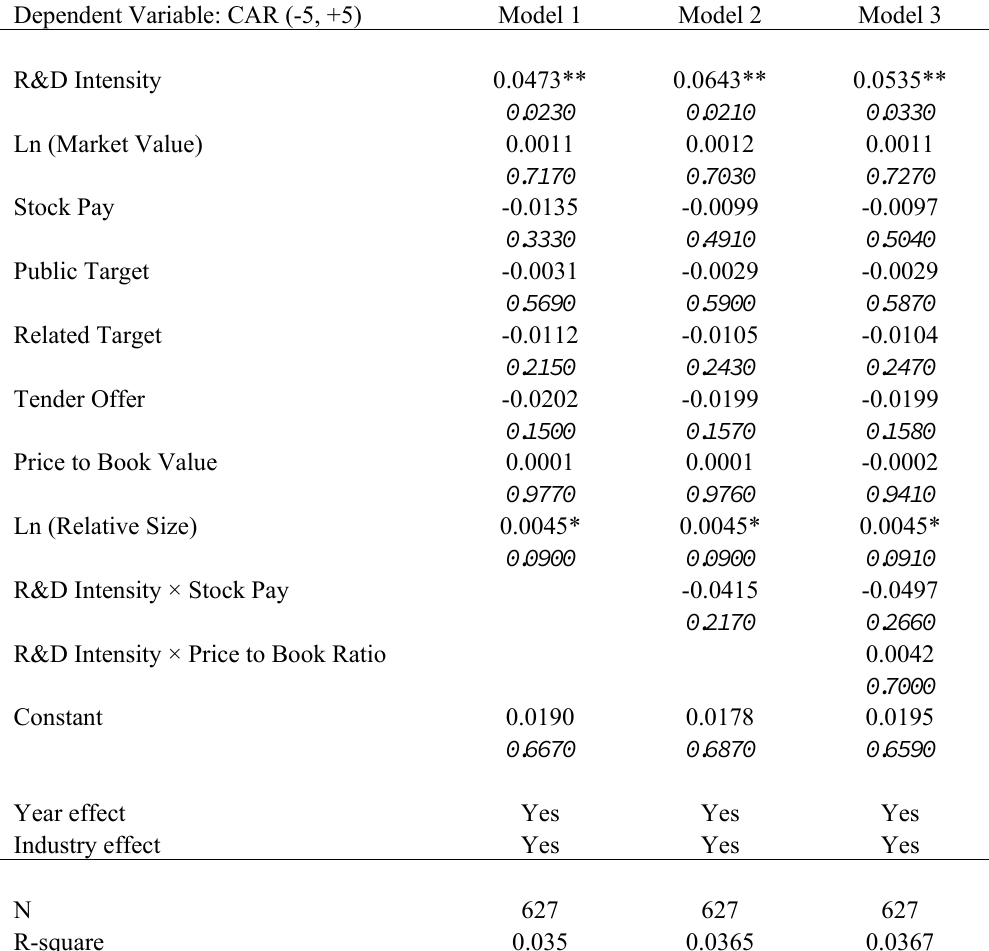
Table 4. Effects of R&D Intensity on Acquirer’s